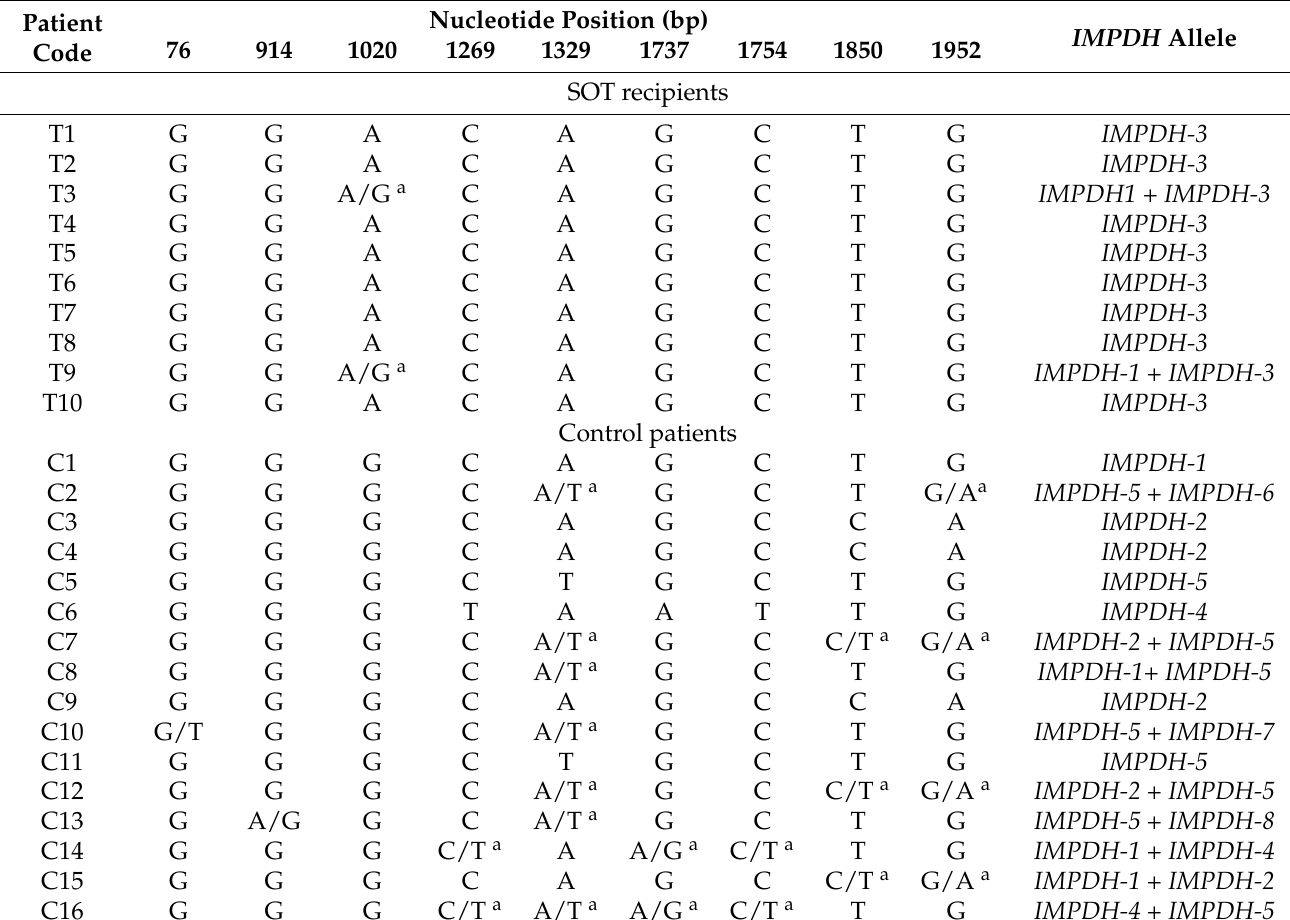
Table 3. Single nucleotide polymorphisms of Pneumocystis jirovecii impdh gene in 10 solid organ transplant recipients with prior exposure to mycophenolic acid and 16 control patients which were not SOT recipients and had no prior exposure to MPA.